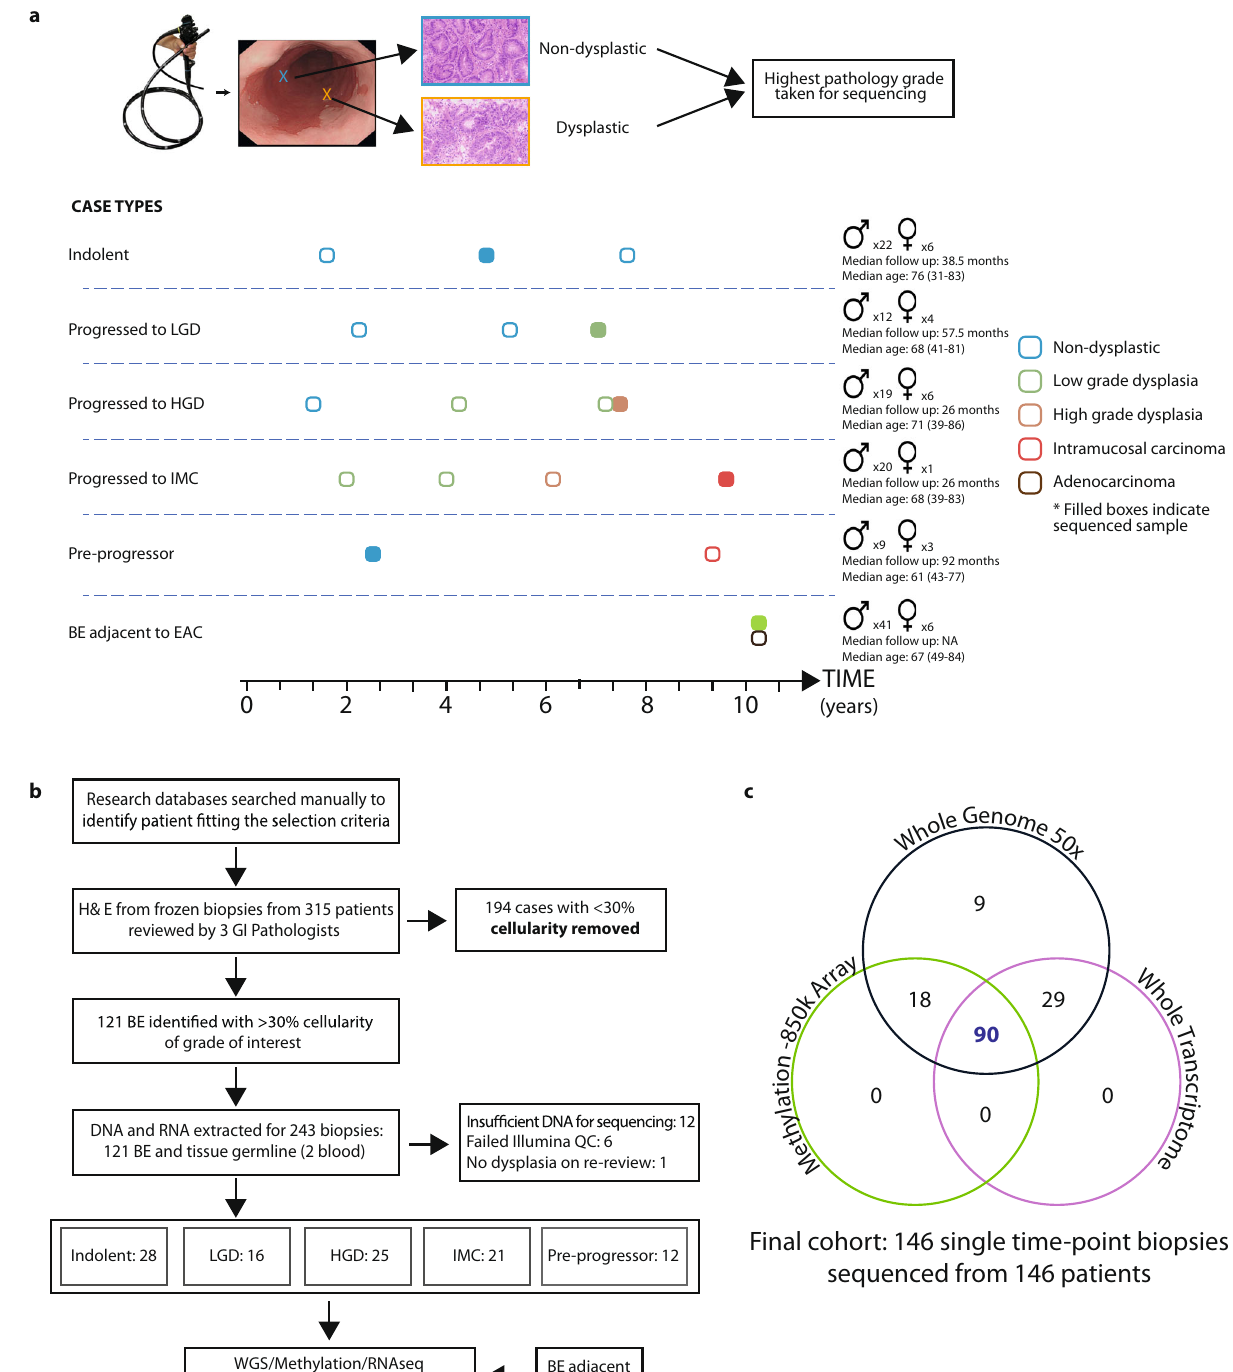
WGS/Methylation/RNAseq (3 failed sequencing: 1 indolent, 2 LGD) Fig. 1 Study design and sequencing strategy. a Examples of representative cases selected for sequencing, with surveillance endoscopies over time and the highest grade at the time point detailed: indolent non-dysplastic; cases which progressed to low-grade dysplasia (LGD) high-grade dysplasia (HGD) or intramucosal carcinoma (IMC); cases sampled prior to progression to dysplasia; Barrett ’ s esophagus (BE) sampled from adjacent to esophageal adenocarcinoma, at the cancer time point. The highest available pathology grade frozen biopsy was used for sequencing. Examples of frozen biopsy histology are shown. Gender, median follow-ups after the sequenced sample and median age and range detailed. b Flow diagram detailing cohort creation. 149 high-cellularity, triple pathology reviewed, single-time point BE biopsies sequenced from 149 individual patients with different disease trajectories were sequenced. c For each patient, one biopsy underwent whole-genome sequencing (WGS) at 50×, whole-transcriptome sequencing and methylation with the EPIC 850k array, where suf fi cient material was available. Three samples were later excluded due to genomic mismatch or poor coverage, resulting in an analysed cohort of 146 patients. The Venn diagram shows the numbers of biopsies sequenced with each